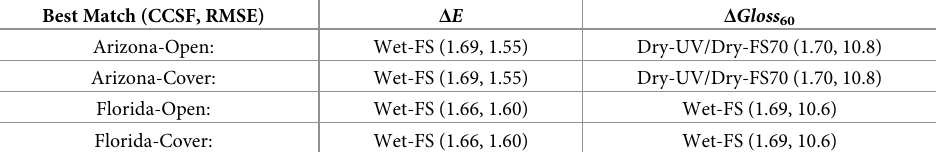
Table 12. Cross-correlation scale factors and RMSE values for the best match indoor sub-model for each outdoor sub-model for white